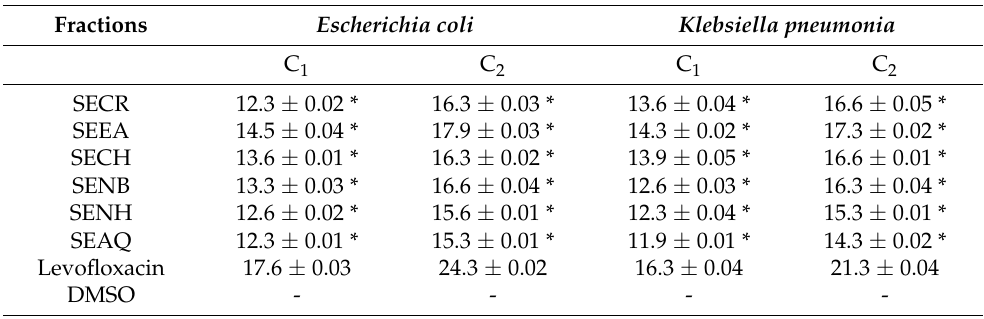
Table 3. Antibacterial activities of different extracts of S. edelbergii . Antibacterial Activities of Extracts and Fractions against Gram-Negative Bacterial Strains